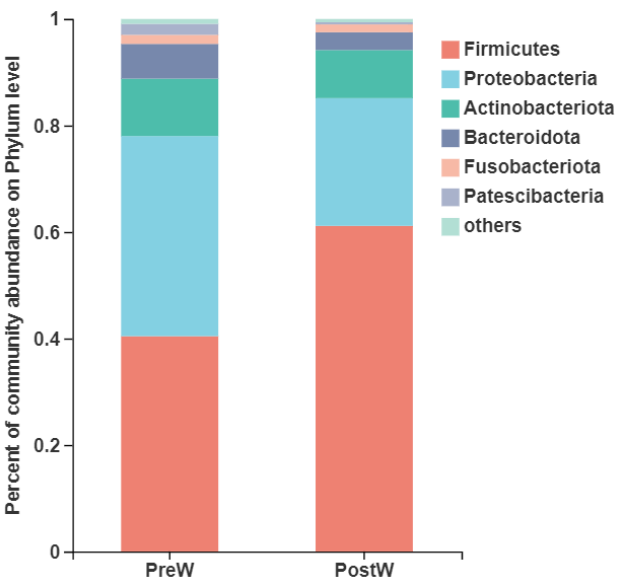
Figure 3. Composition of the predominant oral bacteria at phylum level between preweaning and postweaning donkeys (abundance of the phylum is expressed as %). PreW, preweaning group; PostW, postweaning group.